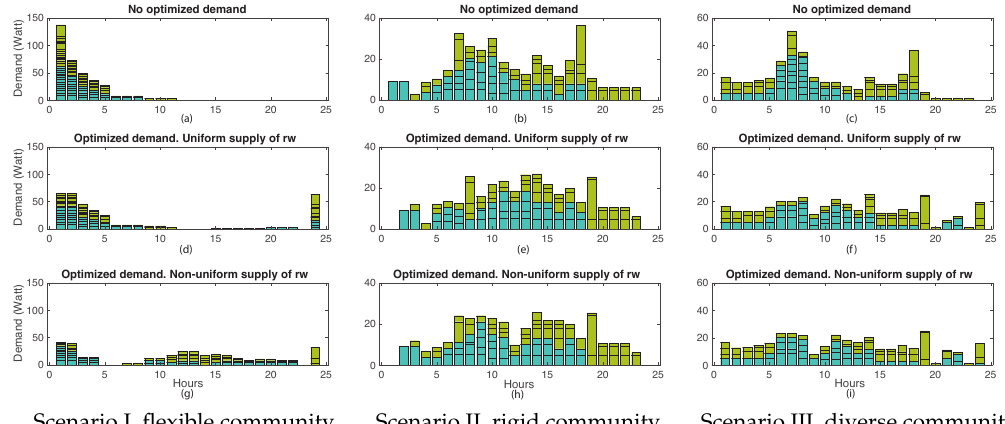
Figure 8. Aggregated vector for two consumers (loads drawn in two colors) prior to the scheduling ( a , b , c ) and as a result of the optimized scheduling with uniform supply ( d , e , f ) and uneven supply ( g , h , i ).